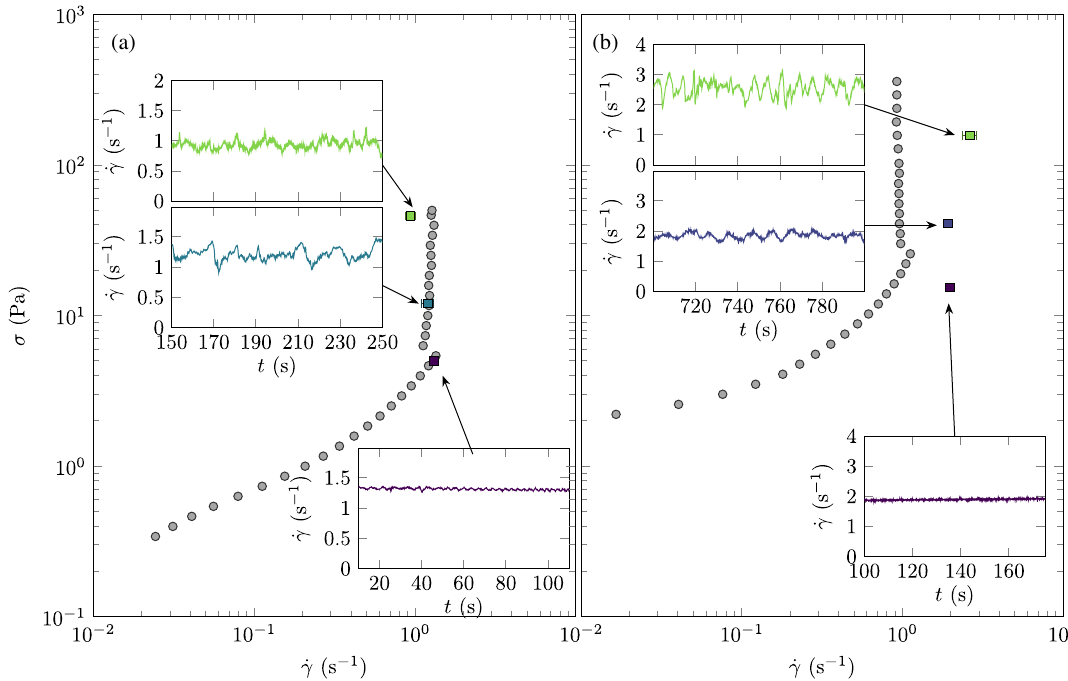
FIG. 18. DST in a dense cornstarch suspension at 41 wt % for two different rough shearing geometries: (a) a small-gap Taylor-Couette cell with a rotor covered with sandpaper and a sandblasted stator and (b) a parallel-plate device with walls covered with sandpaper. The main graphs show the flow curves recorded by ramping up the imposed stress σ with 20 s per point in (a) and 10 s per point in (b) (gray circles) and a few subsequent long experiments under constant stresses (colored circles; the shear rate _ γ is averaged over at least 300 s and error bars correspond to the standard deviation). The insets are snapshots of long time series of _ γ ð t Þ for three different imposed stresses across